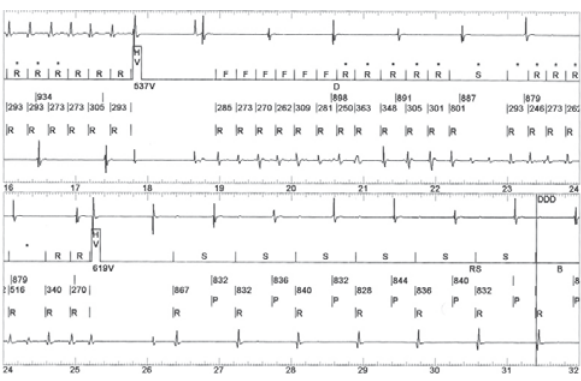
Fig. 3 – Primeira desfibrilação ventricular com 15 J sem sucesso. Segunda desfibrilação ventricular com 20 J e reversão ao ritmo sinusal